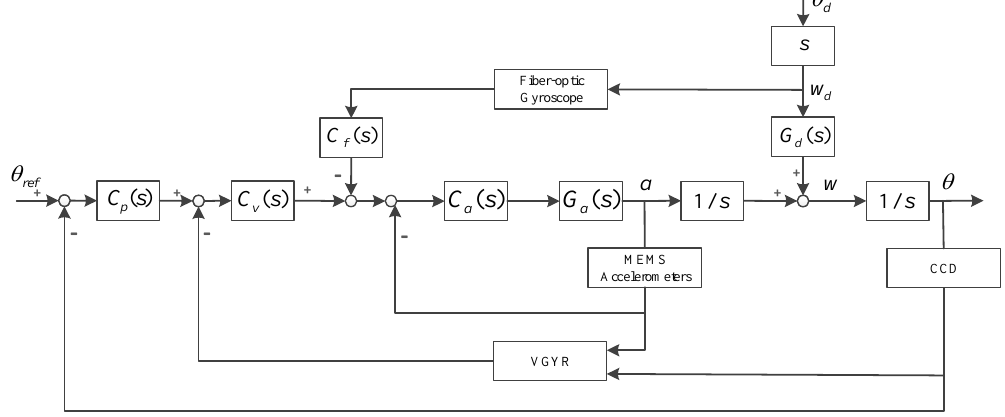
Figure 6. Virtual multi-loop feedback control system with measured disturbance feedforward method.